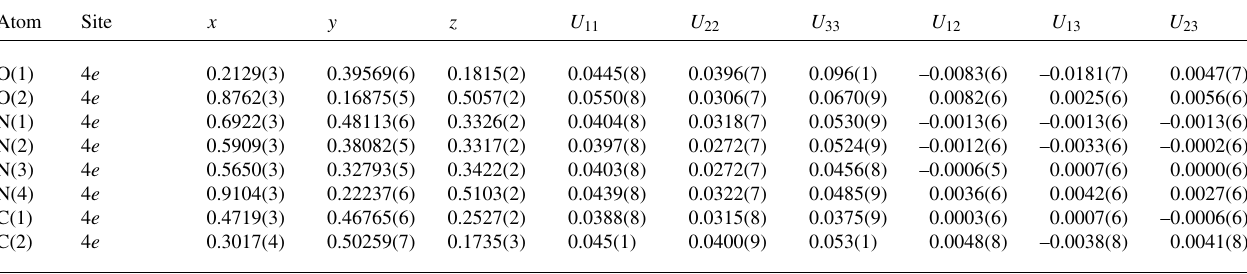
Table 3. Atomic coordinates and displacement parameters (in Å 2 ) .